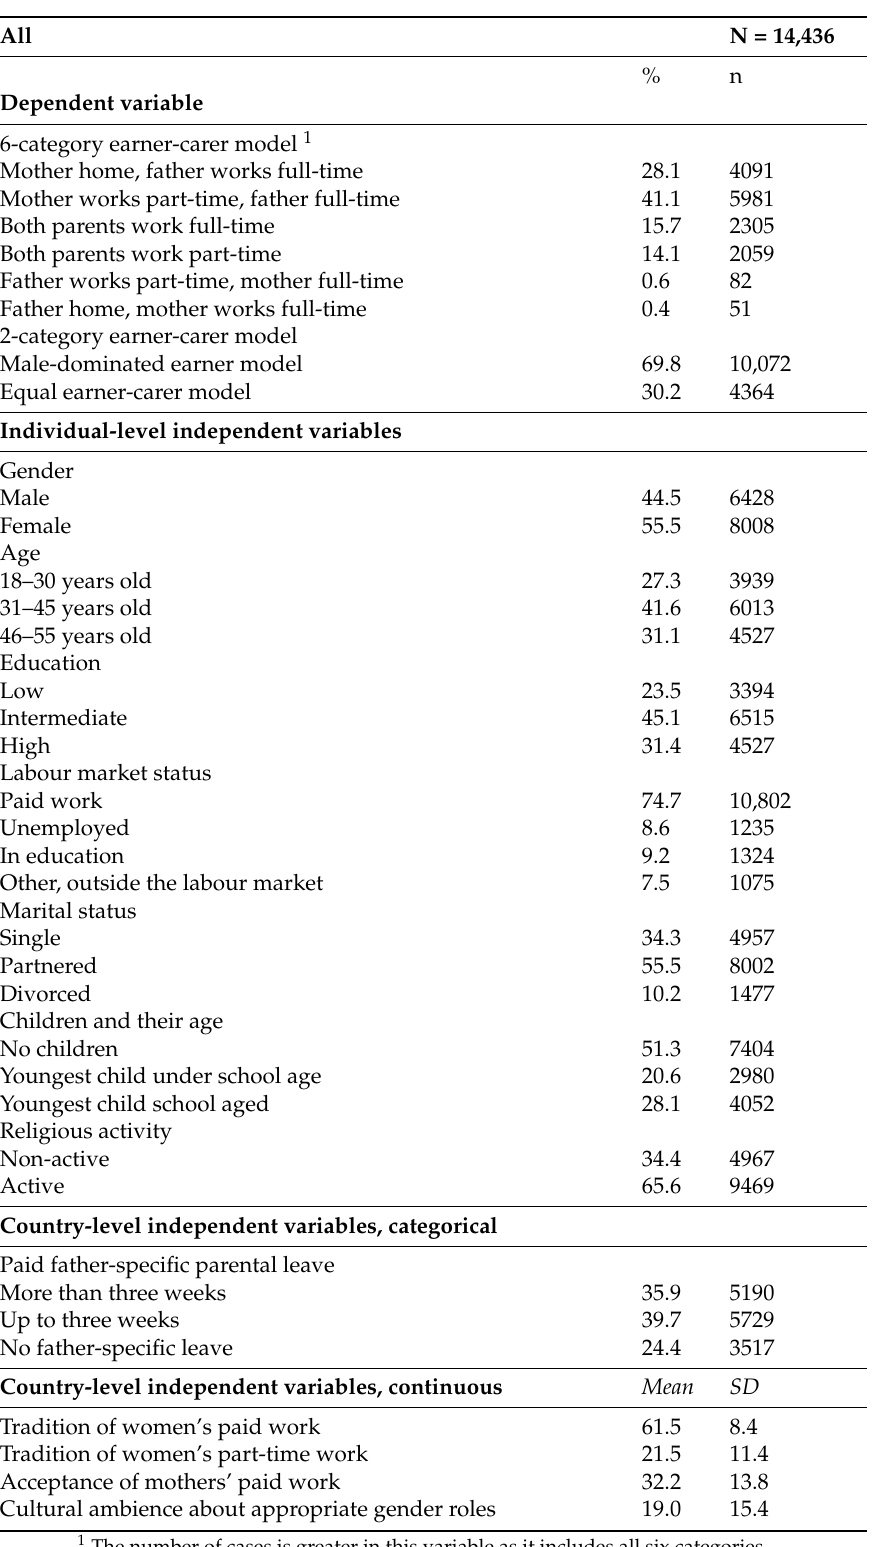
Table 1. Descriptive statistics for dependent and independent